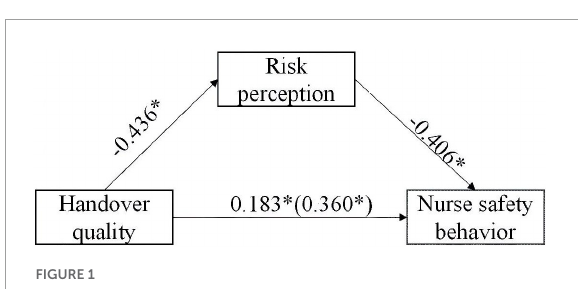
FIGURE1 Mediation model of risk perception on handover quality and nurse safety behavior * P <